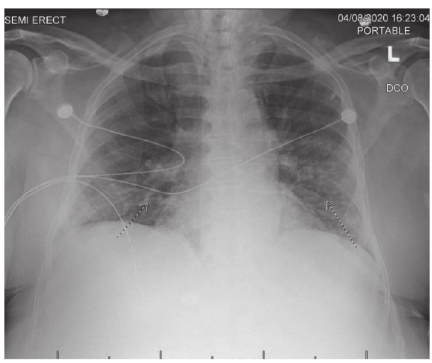
Figure 1: Portable chest X-ray showing bilateral interstitial infiltrates on